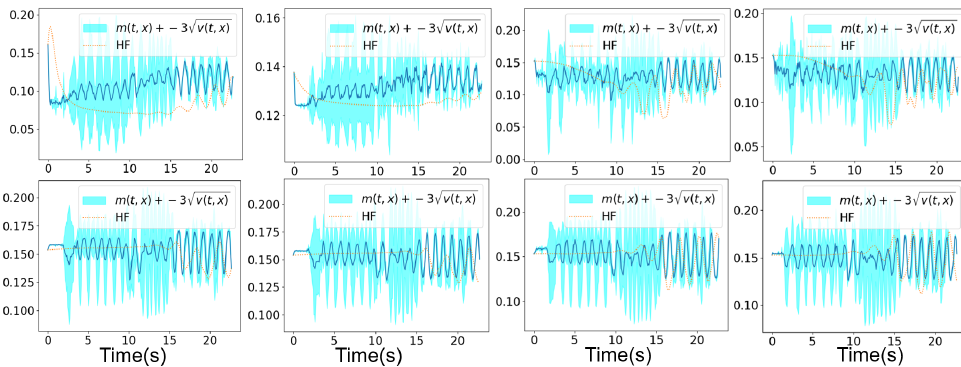
Figure 13. Mesh n°2: High-fidelity Yales2 horizontal velocity projected on the Cartesian mesh in brown and the horizontal component of the mean prediction of the Bayesian ROM in dark blue, at eight different spatial locations. The training data correspond to 15 s simulation time starting from 0 s. An extrapolation is performed from 15 s until 22.64 s. The clear blue zones are the ones contained in three standard deviations around the mean prediction of the ROM denoted m ( t , x ) . The mean prediction is obtained using an aggregation of three samples of the Navier–Stokes solution by the Bayesian nonlinear ROM.